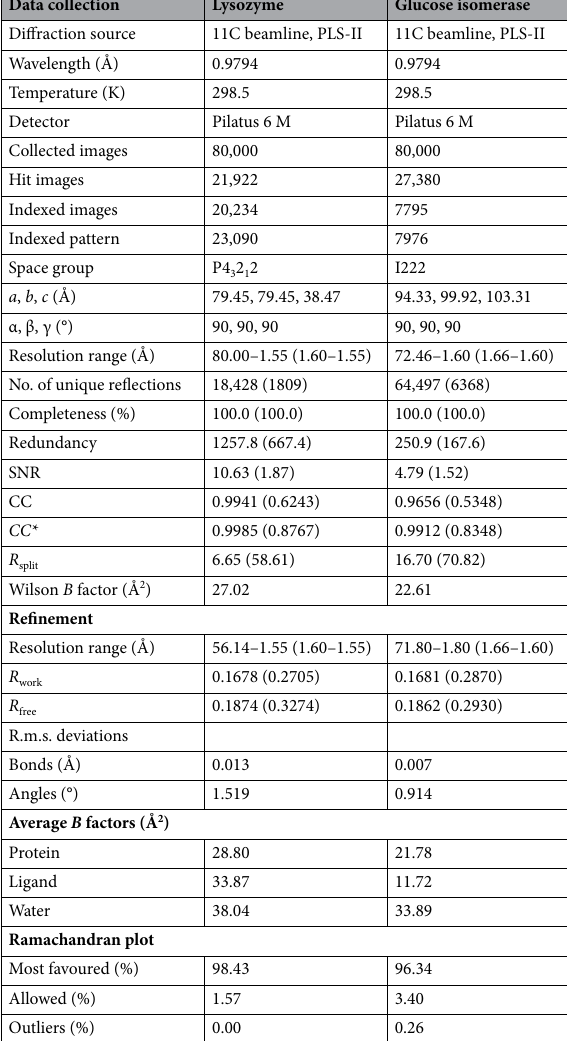
Table 1. Data collection and refinement statistics for lysozyme and glucose isomerase delivered in beef tallow injection matrix. Values for the outer shell are given in parentheses. R split = (cid:31)